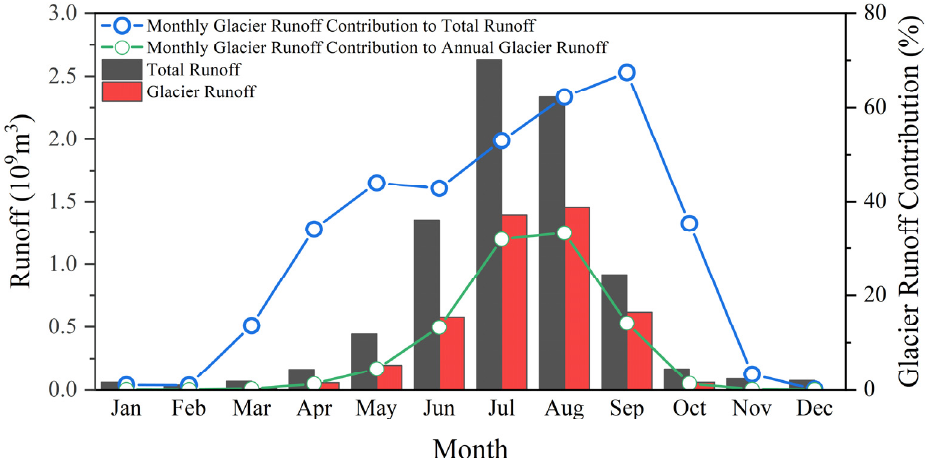
Figure 8. Simulated total runoff and glacier runoff contributions on the multi-year monthly level in the UYR basin.